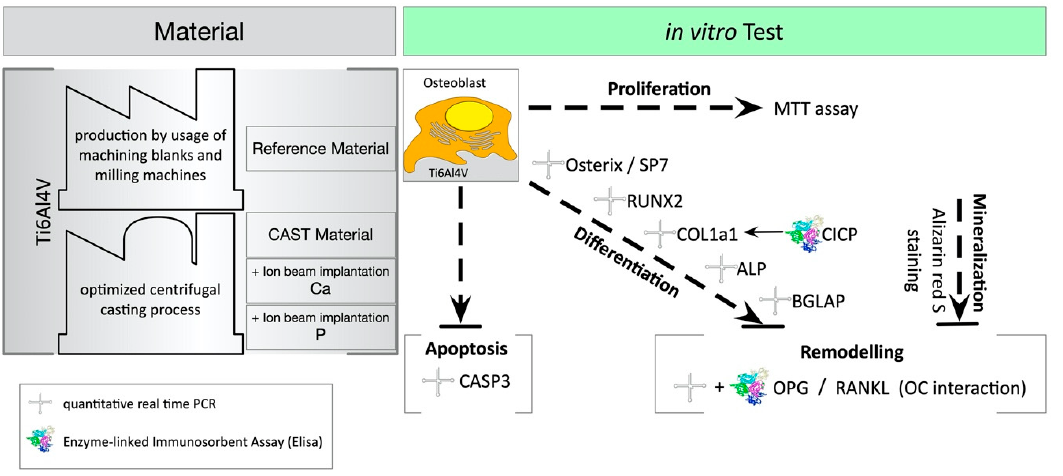
PCR: gene expression analysis of di ff erentiation markers. Osterix / SP7: a transcription factor that is highly conserved among bone-forming cells and responsible for osteogenic di ff erentiation. RUNX2: Runt-related transcription factor 2 associated with osteoblast di ff erentiation. COL1a1: collagen type I alpha 1 as one chain of collagen type I—the major structural protein of bone. CICP: type I C-terminal collagen propeptide. ALP: tissue non-specific Alkaline phosphatase. BGLAP: osteocalcin, also